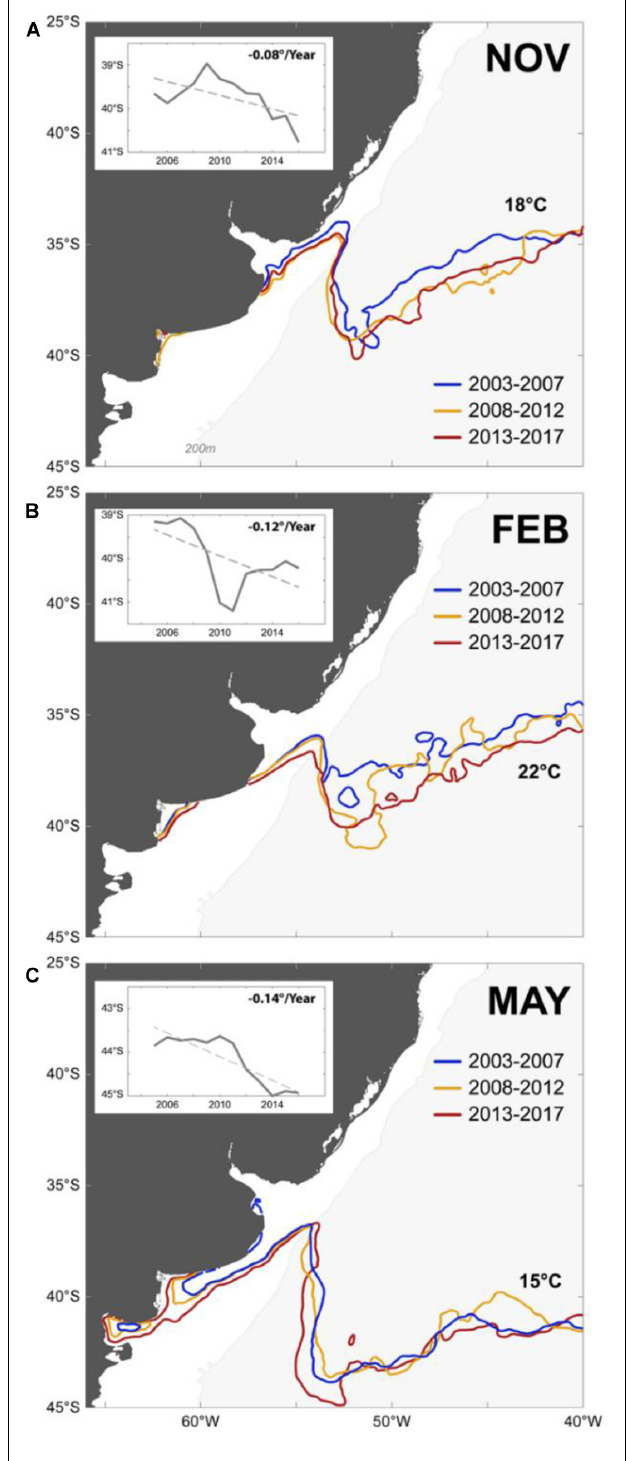
FIGURE 6 | Changes in the thermally accessible habitat range of the green sea turtle ( Chelonia mydas ) from 2003 to 2017 in the SWAO. The southward displacement of the surface isotherms likely drove the species distribution is shown for the representative months of the (A) “arriving,” (B) “remaining,” and (C) “leaving” periods. The inset shows the southward movement (latitude/year) of the mean isotherms for each